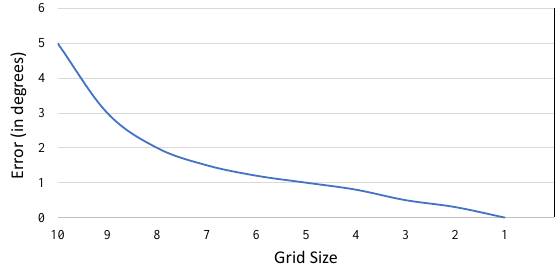
Figure 13. Accuracy of swing visualization w.r.t. the grid